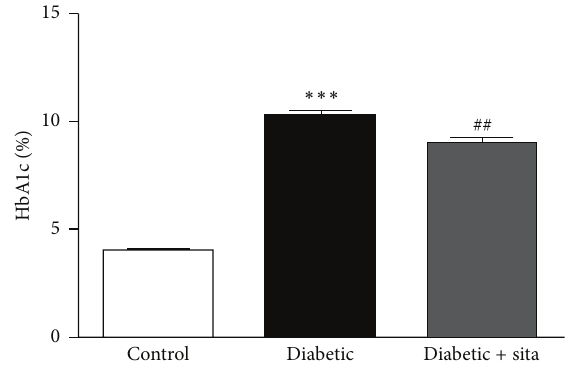
Figure 1: HbA 1 levels in control nondiabetic ZDF (+/+) and c diabetic ZDF ( fa/fa ) rats nontreated and treated with 10 mg/kg/day sitagliptinfor6weeks,at26weeksofage.Dataareexpressedasmean ± SEM ( 𝑛 ≥ 6 per group); ∗∗∗ 𝑃 < 0.001 significantly different from control; ## 𝑃 < 0.01 significantly different from